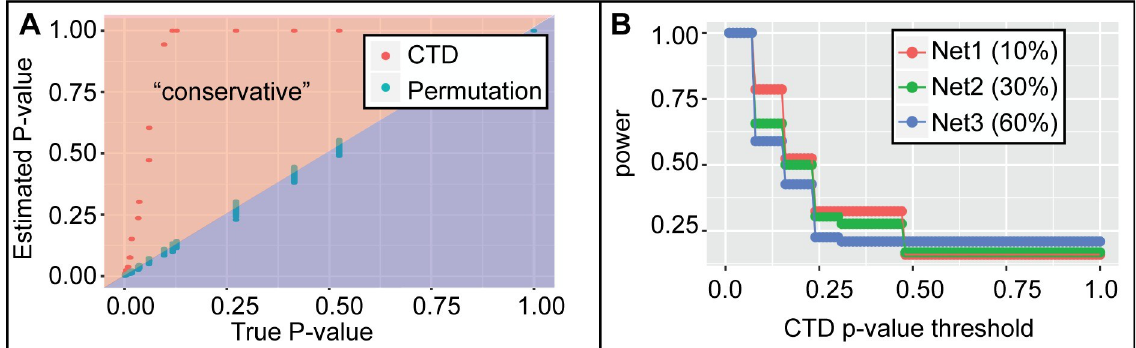
Fig 4. Power of indirect CTD p-value estimation compared to permutation-based p-value estimation. For three separate network structures containing 50 nodes at variable levels of connectedness (network 1: 10% connected; network 2: 30% connected; network 3: 60% connected), p-values for node sets of size 5 were estimated by three estimation methods: “ground truth” enumeration, permutation-testing and (cid:0) � upper bound estimation by CTD. Ground truth was calculated via brute force enumeration for all 50 ¼ 2 ; 118 ; 760 node set outcomes of size 5 5. (A) CTD p-value bounds were more conservative than permutation-based p-value estimates. However, for highly connected node sets which were given more significant p-value bounds by CTD, the difference between CTD’s upper p-value bounds and the ground truth p-value is smaller. (B) Power associated with CTD upper-bounds on p-values was estimated. For all experiments where the brute force p-value was less than or equal to a given significance level (e.g., 0.05), power is calculated based on the percentage of those experiments where the CTD upper bounds p-value estimate was also less than or equal to the given significance threshold (i.e., the true positive rate). Similar to the view of the data in (A), we see that CTD’s p-value bounds show higher power for highly connected node sets compared to sparsely connected node sets.